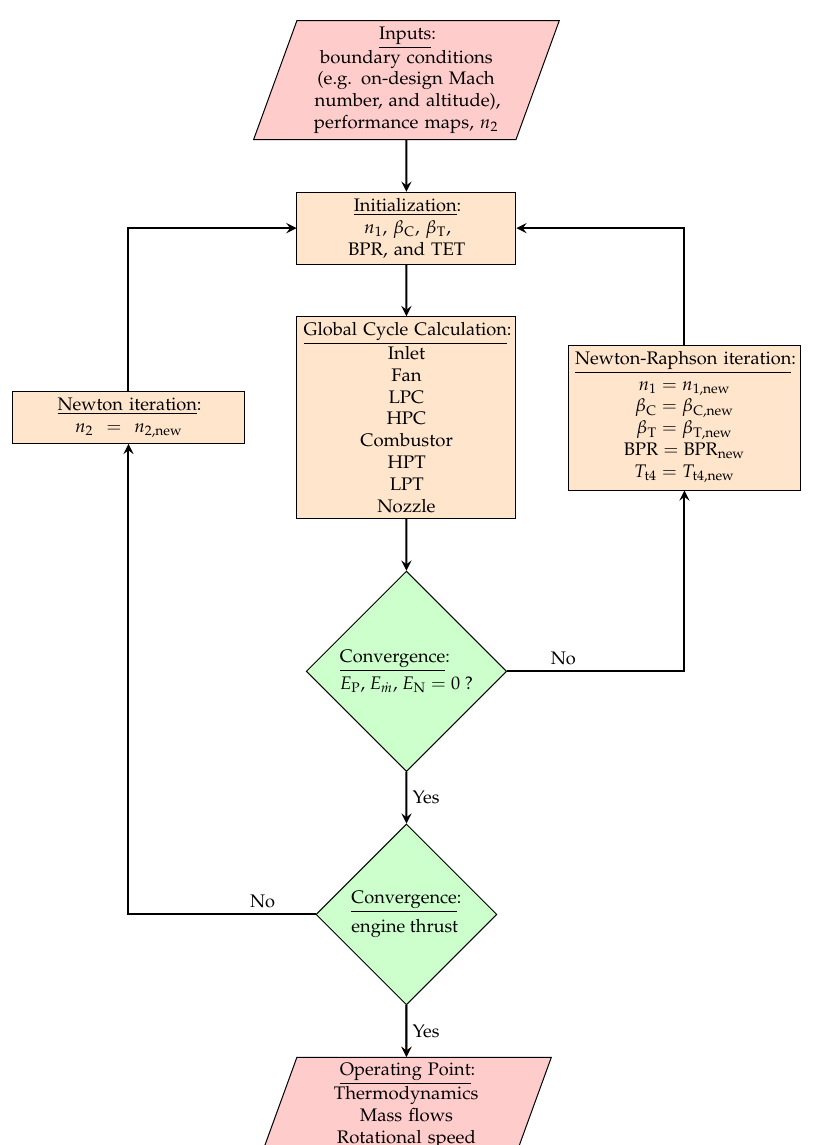
Figure 2. Global off-design calculation procedure for high-bypass turbofans. The off-design calculation procedure consists of an iterative simulation process which requires various input data, such as the altitude, Mach number and engine thrust along the aircraft’s trajectory. These are modeled by the flight trajectory and performance calculation tool described in Section 2.1 depending on the aircraft type. Moreover, further jet engine- specific boundary conditions are required, the thermodynamic cycle at a reference point being a crucial one, also referred to as the engine’s on-design operating point. This point represents the basic framework of the jet engine and defines the interaction of the miscella- neous turbomachines, secondary air system, geometry (e.g., nozzle area) and number of revolutions in order to fulfill the thermodynamic cycle. Mostly, the on-design operating point is based on cruise or top of climb conditions. Table 1 presents the reference operating values considered for the cruise performance of both jet engines modeled in this work to develop their entire thermodynamic cycle, namely, thrust, overall pressure ratio (OPR) (product of fan, LPC and HPC pressure ratio P ), fan rotational speed n 1 , rotational speed of the high-pressure system n 2 , specific fuel consumption (SFC) and the bypass ratio